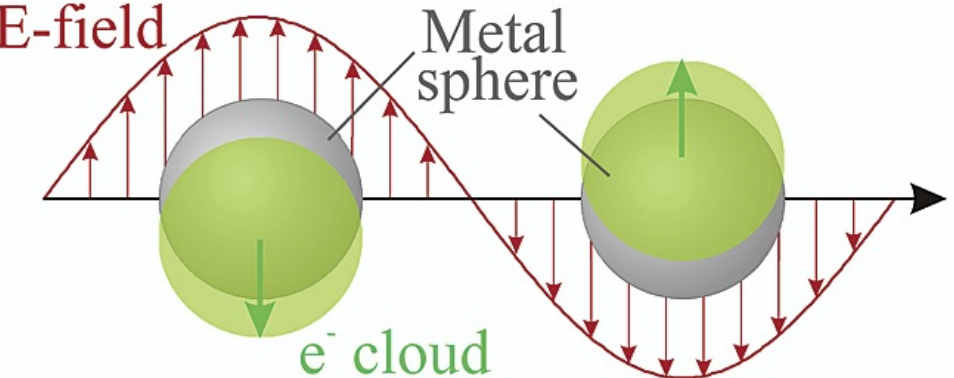
Figure 1. Schematic illustration of the displacement of the conduction electron cloud relative to the nuclei induced by the electromagnetic wave. Reproduced with permission from [8]. Copyright 2002 American Chemical Society.